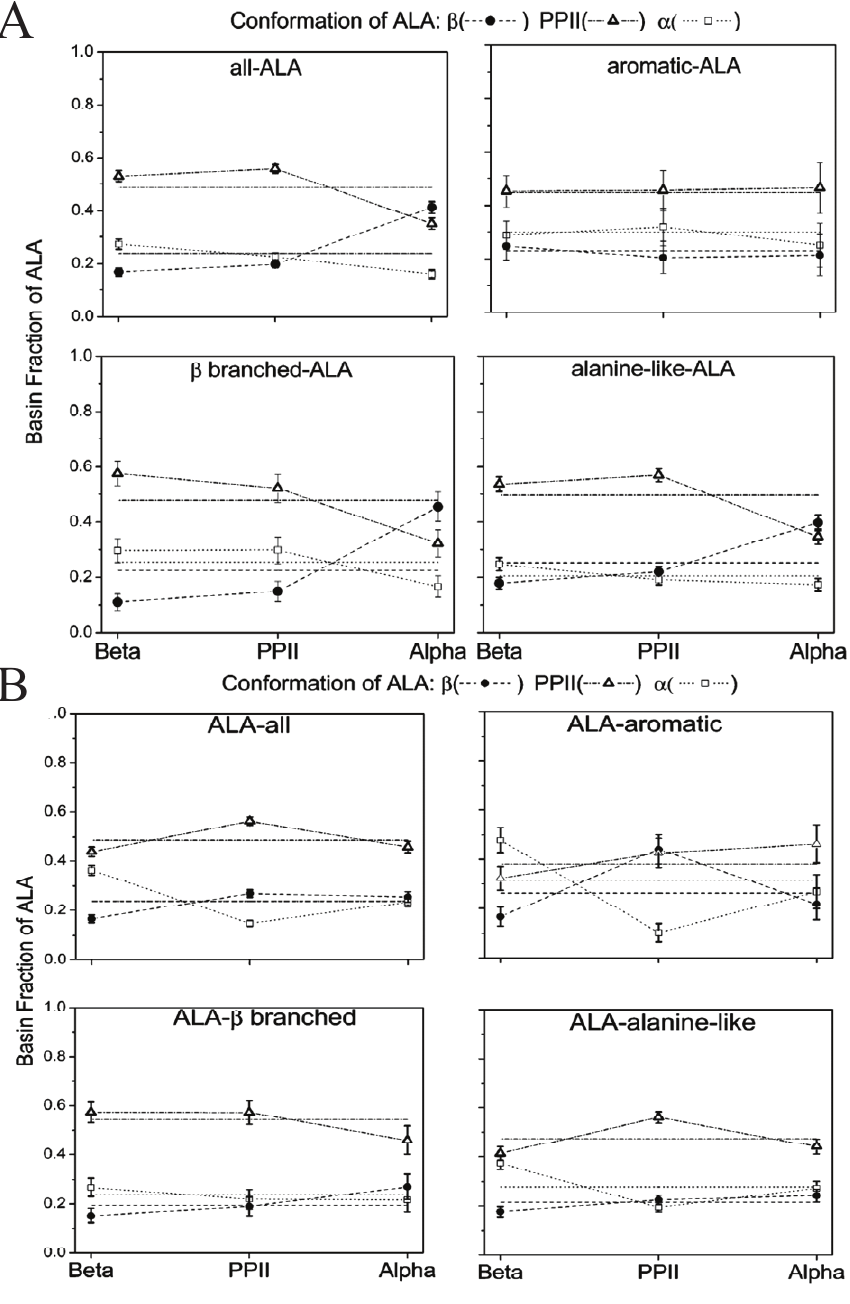
Figure 20. Representation of the change of the electrostatic solvation free energy induced by substituting the fifth alanine residue of a hepta-alanine peptide by valine. Changes are plotted for pPII and (cid:8)-strand conformations, as indicated. Taken form ref. [81] and